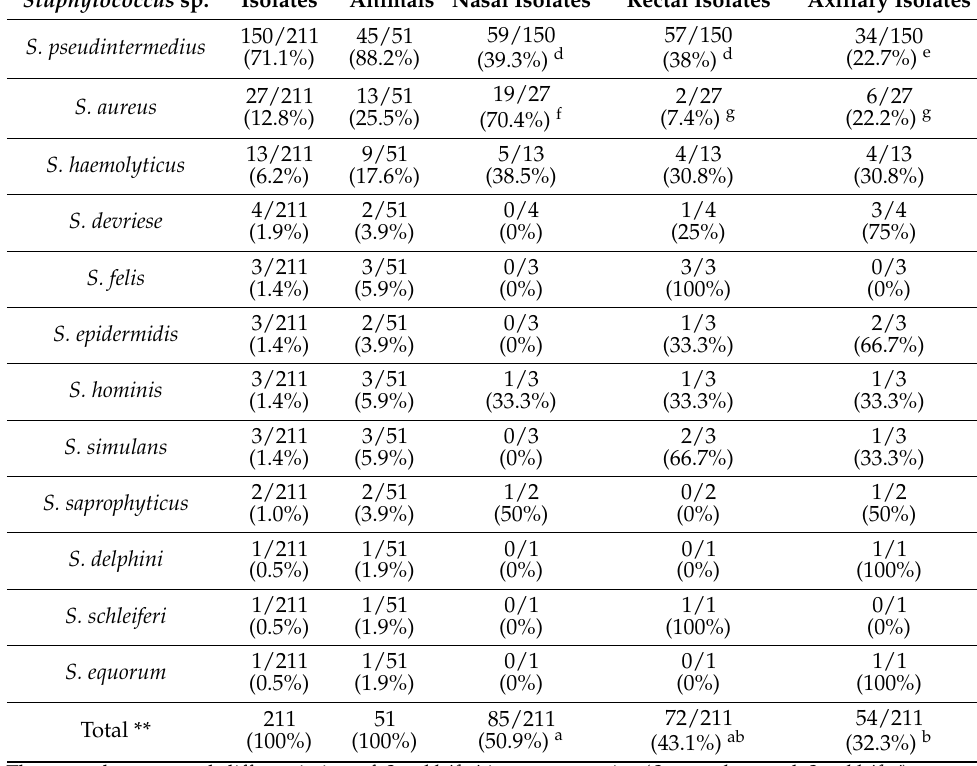
Table 3. Species distribution and frequency of isolates (total and per collection site). Staphylococcus